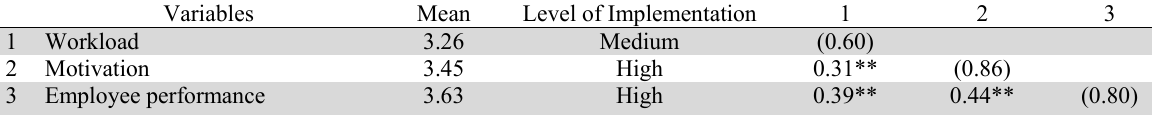
Means, Level of Implementations, Correlatioans,